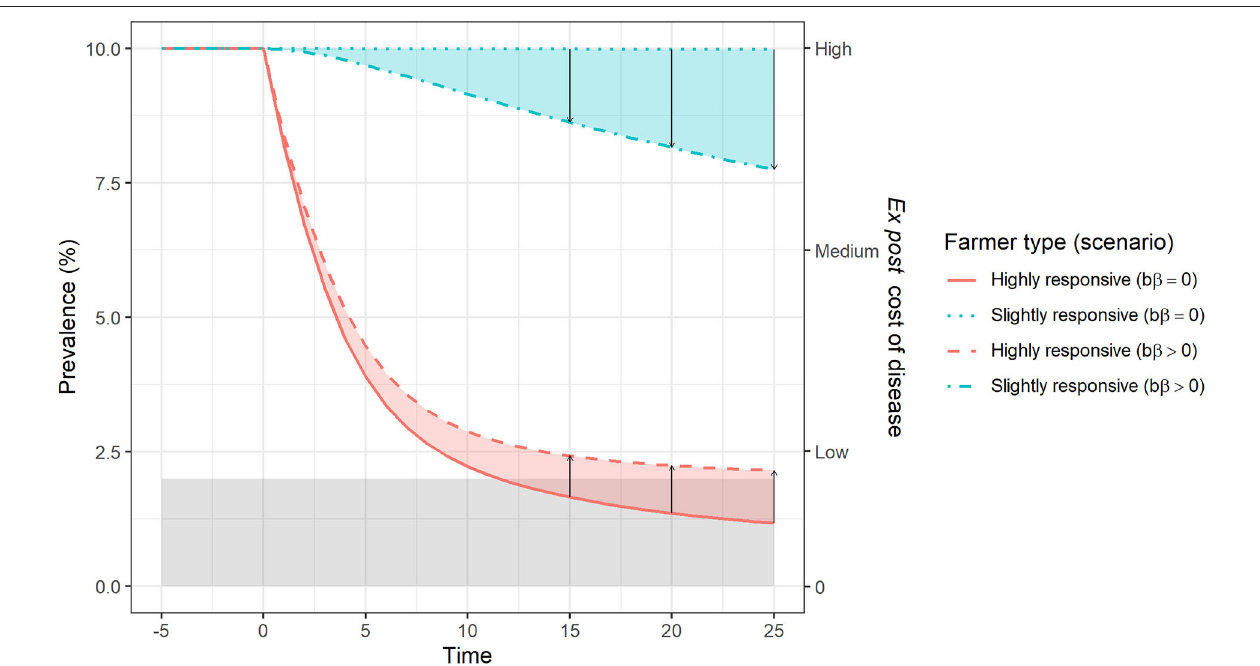
FIGURE 2 | Externalities occurring as a result of different effort to achieve disease control in two neighboring farms. Arrows indicate a simulation scenario shift, from absence of transmission between farms (b β = 0) to a situation in which between-farm transmission is possible (b β > 0). Assuming an ex post cost per infected animal per time step ( δ ) of 50 monetary units, the labels “Low,” “Medium,” and “High” on the right vertical axis correspond to 313, 781, and 1,250 monetary units. Blue and red shaded areas correspond to the positive and negative externalities, respectively. The gray shaded area indicates the target prevalence level from society’s perspective ( <